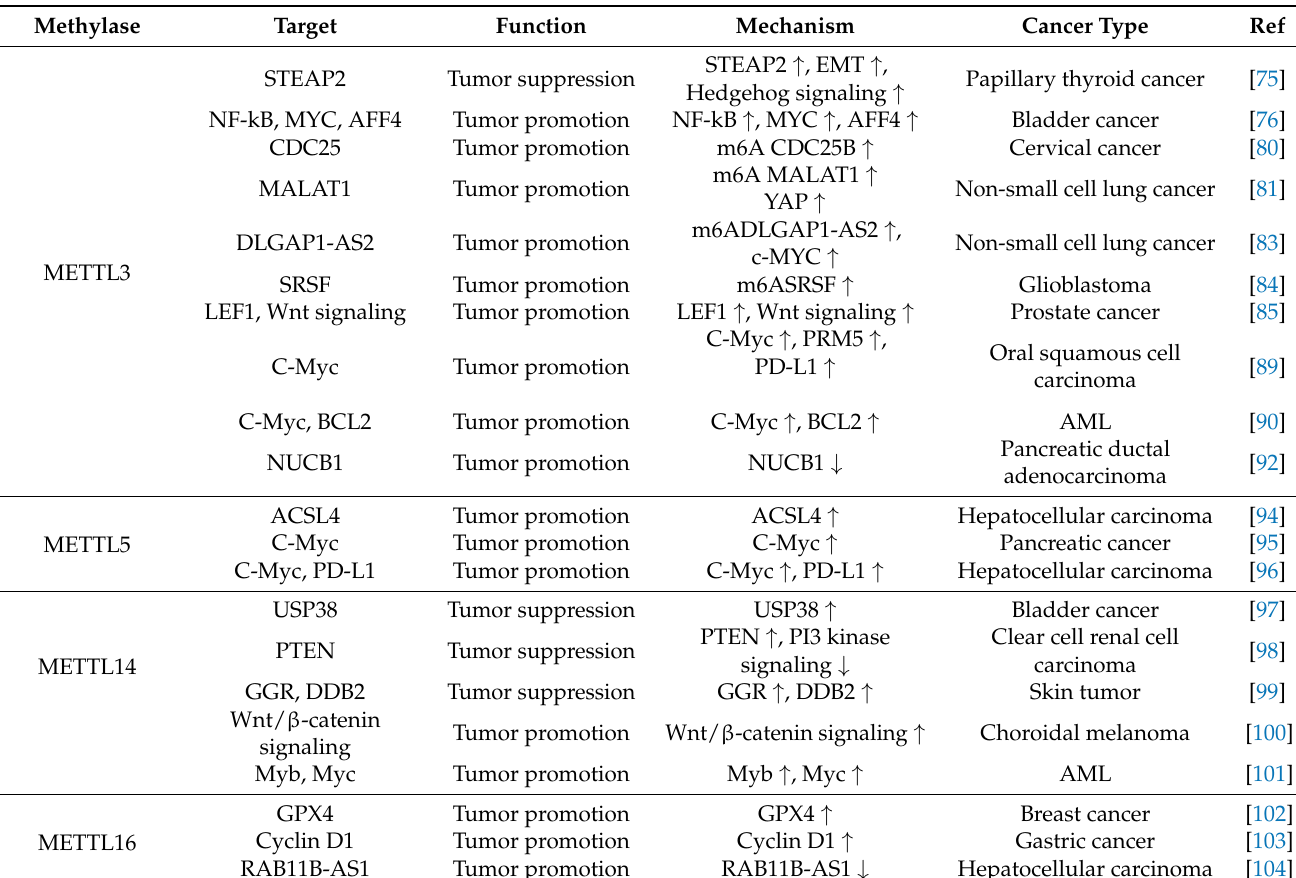
Table 2. Roles and targets of RNA methyl transferases in